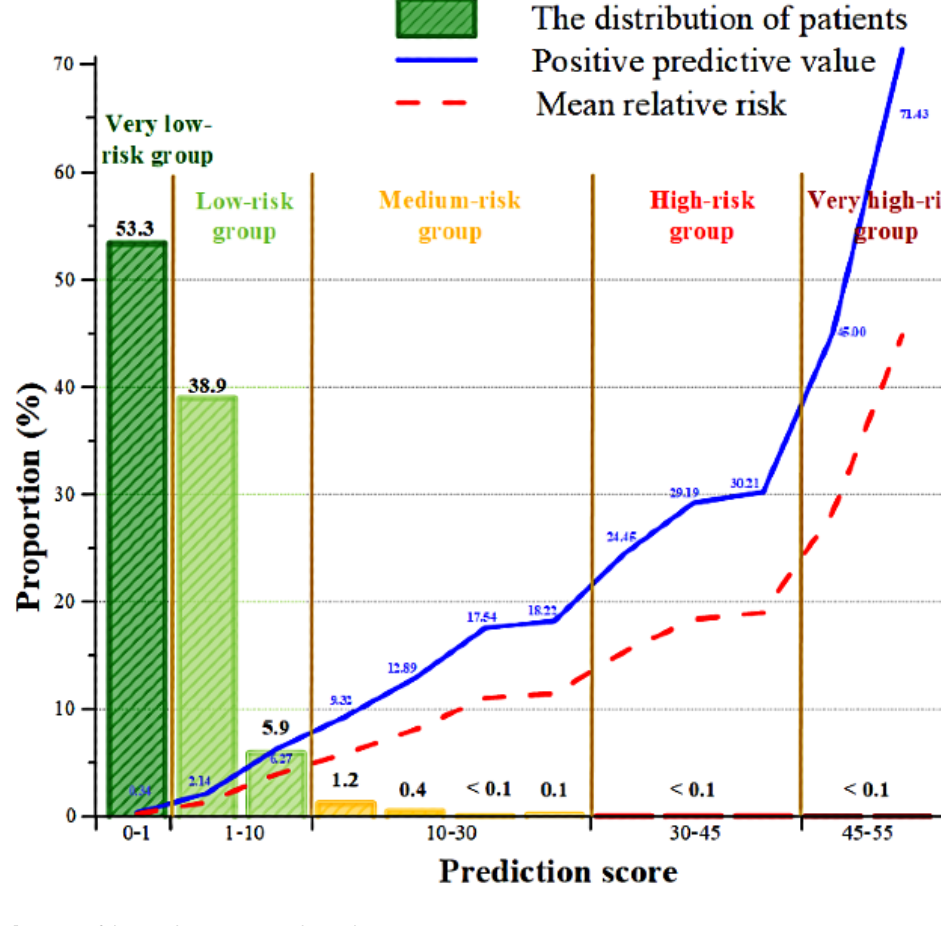
Figure 6. Survival curves of the 5 risk groups. HR: hazard